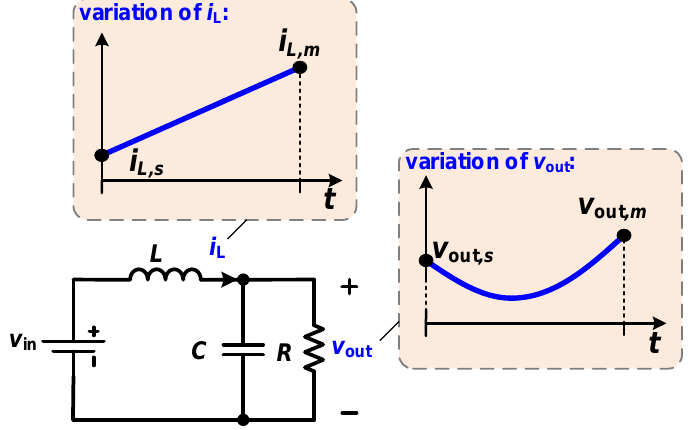
Figure 3. Equivalent circuit scheme and state variations of the buck converter during switching-ON.